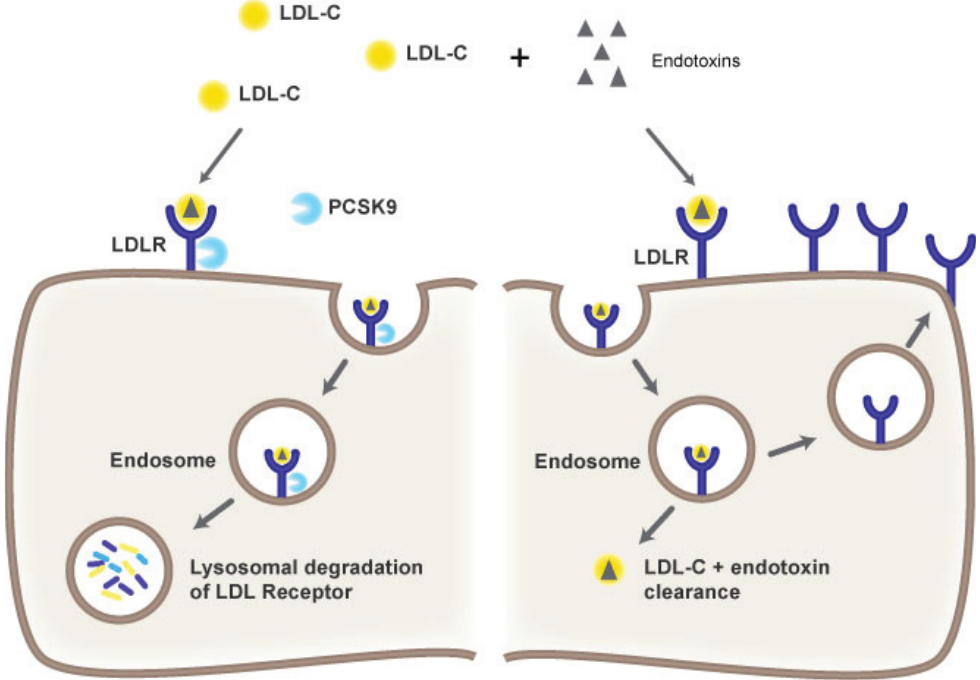
Figure 1. Pathogen lipid clearance from the circulation. Pathogen lipids, such as endotoxins from Gram-negative bacteria and lipotechoic acid from Gram-positive bacteria, are carried within high-density lipoprotein (HDL), low-density lipoprotein (LDL), and very low-density lipoprotein (VLDL) particles in the blood. Pathogen lipids contained within LDL cholesterol (LDL-C) are then cleared via LDL receptors (LDLR) expressed on hepatocytes. The left hand panel illustrates the role that proprotein convertase subtilisin/kexin type 9 (PCSK9) plays in modulating clearance. PCSK9 binds the LDLR and when LDLR is internalized, as part of hepatocyte uptake of LDL-C, bound PCSK9 targets the LDLR for lysosomal degradation. As a result, LDLR density on the hepatocyte cell surface diminishes. The right hand panel shows that when PCSK9 concentrations are reduced, LDLR density increases so that the clearance of LDL-C is increased. In the setting of sepsis, when LDL-C carries pathogen lipids, increased LDLR density also results in the increased clearance of pathogen lipids, leading to a diminished inflammatory response and improved sepsis